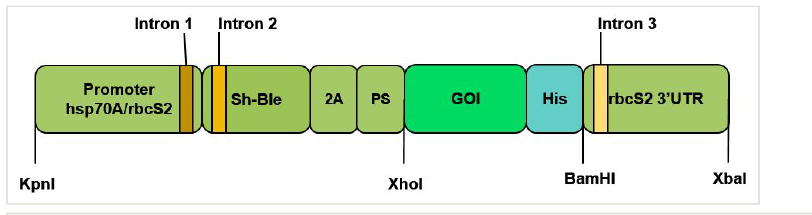
Figure 3. Cassette construction to be inserted in C. renhardtii nuclear genome for the expression of desired proteins. Promoter hsp70A/rbcs2 : fusion of the promoters hsp70A and rbcs2 (Eichler-Stahlberg et al. 2009, Schroda et al. 2000). Sh-Ble : gene that gives resistance to Zeomycin. 2A : self-cleavage peptide obtained from Foot and Mouth Disease Virus (FMDV) (Rasala et al. 2012). PS : Secretion signal peptide of the gene Ars1. GOI : gene of interest coding the proteins to be used in the project. His : coding sequence of six histidines (histidine tag). RbcS2 3’UTR : terminal sequence (untranslated region) of the gene RbcS2 (Fuhrmann et al. 1999)